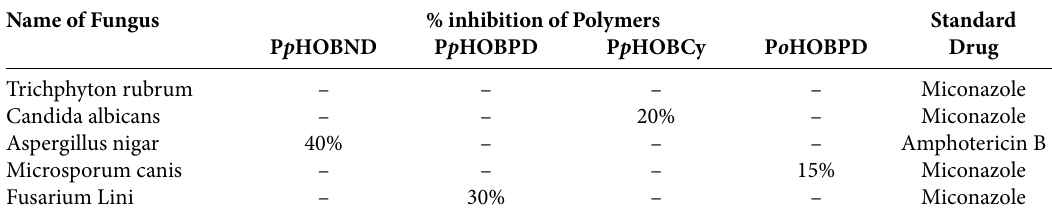
Table 5: Results of antifungal activities of polymers in DMSO solvent Name of Fungus